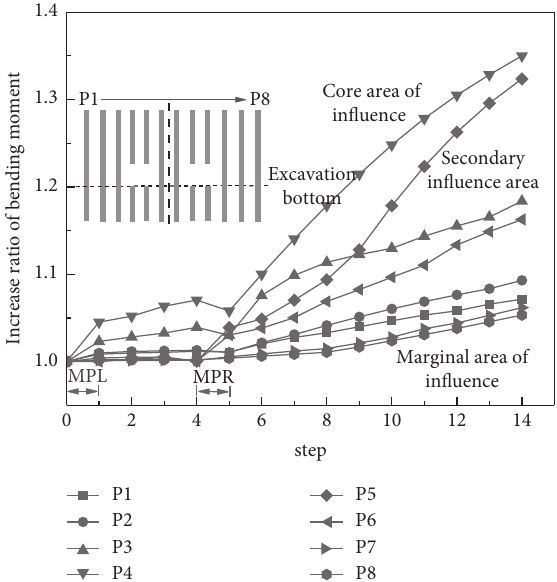
Figure 11: Variation of bending moment ( I